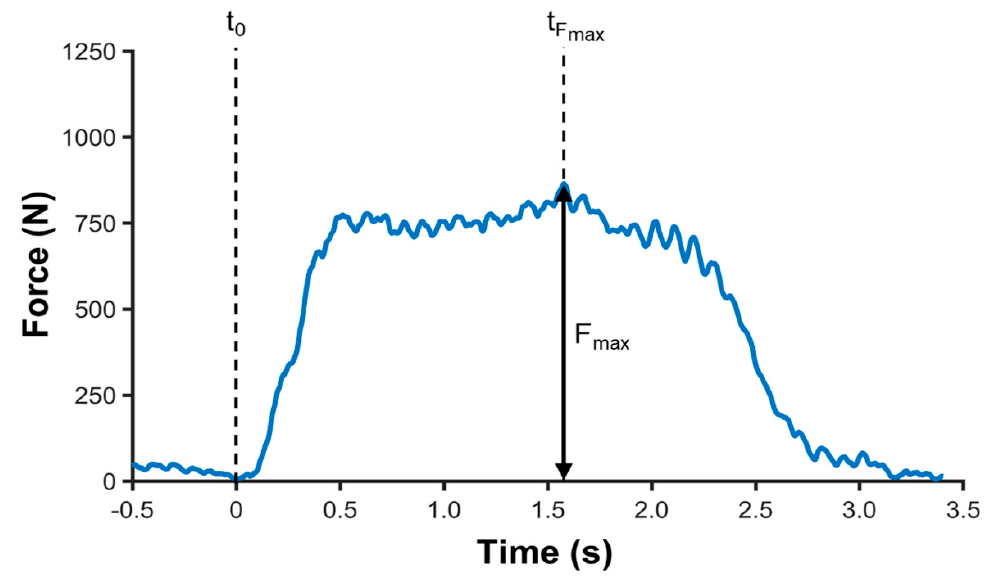
Figure 3. Determination of MIVC. Exemplary MIVC determination is illustrated on a single force–time curve. Force–time onset (t 0 ), peak force value (F max ), as well as time to peak force value (t Fmax ) are highlighted.